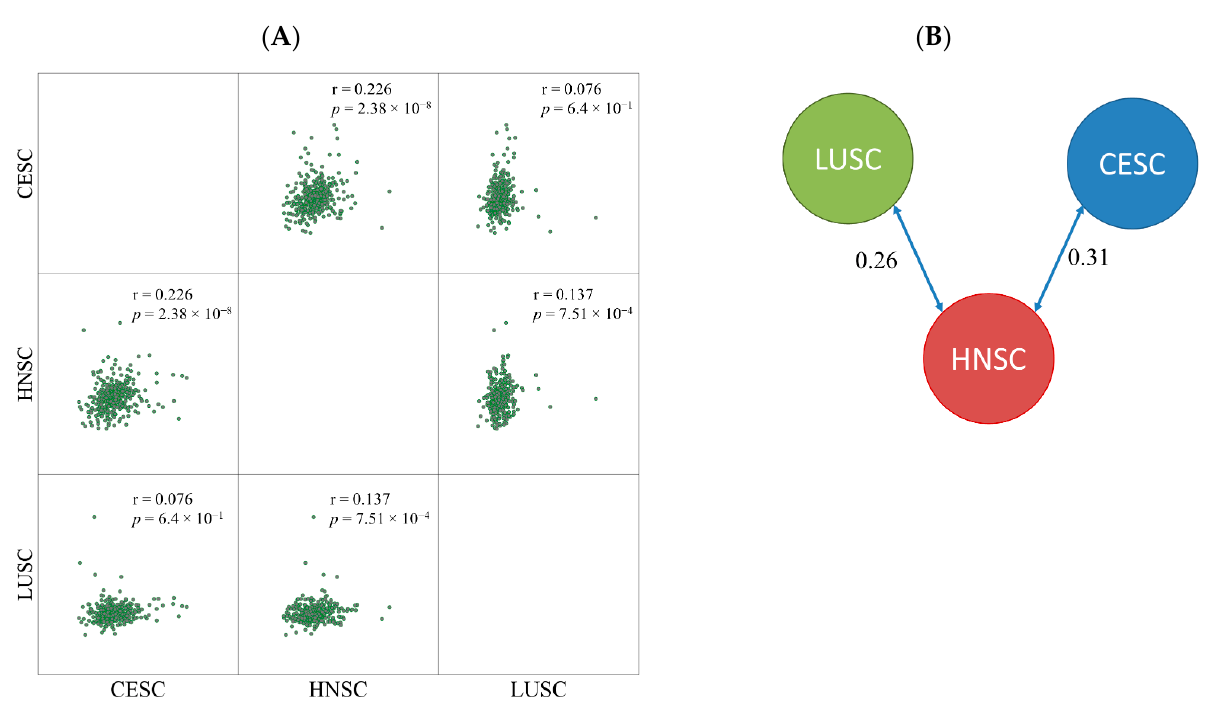
Figure 2. Pairwise comparison of fold changes by Pearson correlation ( A ) and similarity index determined by clustering ( B ).